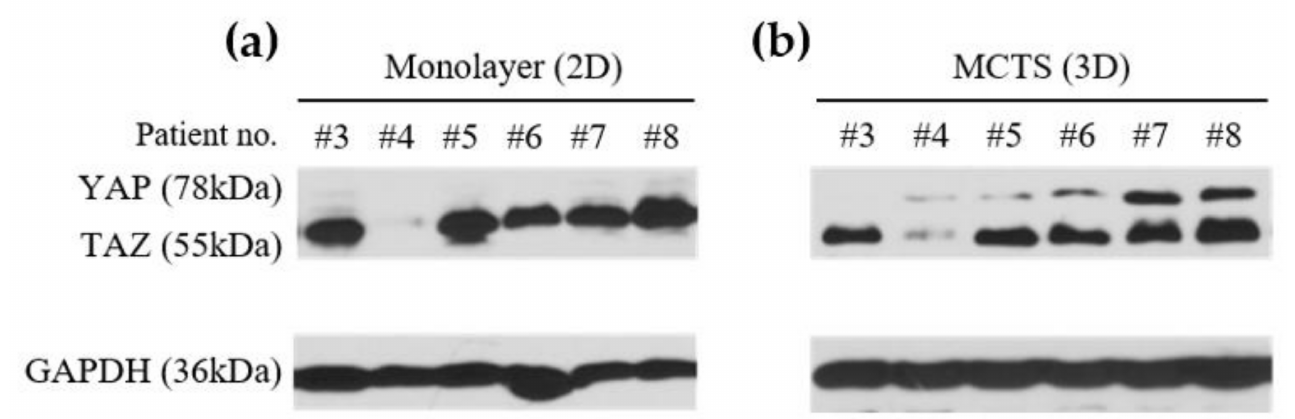
Figure 6. Comparison of YAP/TAZ expression using western blot between monolayer HCCs (2D) and MCTS (3D). For the original Western blots, see Supplementary Figure S1. ( a ) Different expression of YAP/TAZ were assessed by Western blot analysis using monolayer patient-derived HCCs (2D). ( b ) Lysates of MCTS derived from patient-derived HCCs were analyzed by Western blotting with anti-YAP/TAZ and anti-GAPDH (control) antibodies.